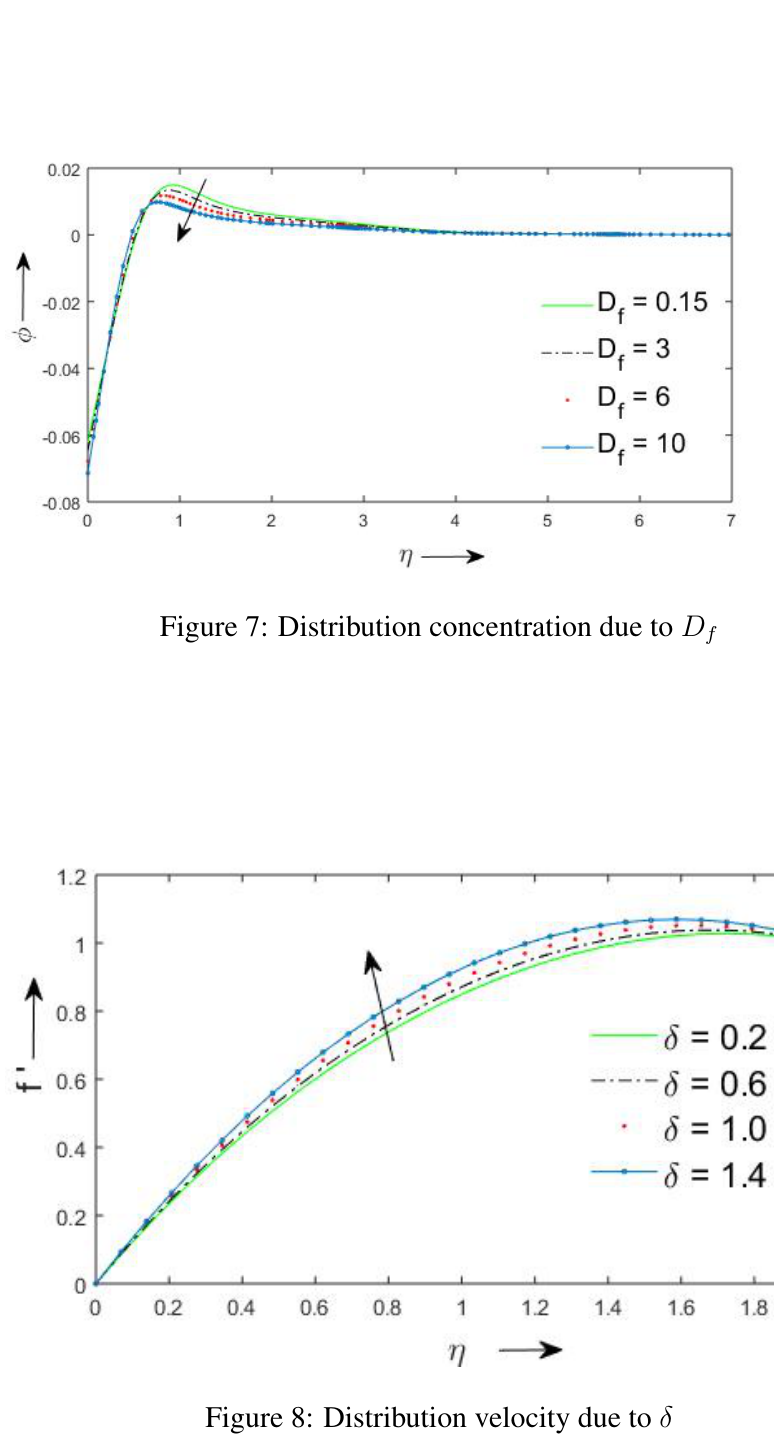
Figure 8: Distribution velocity due to